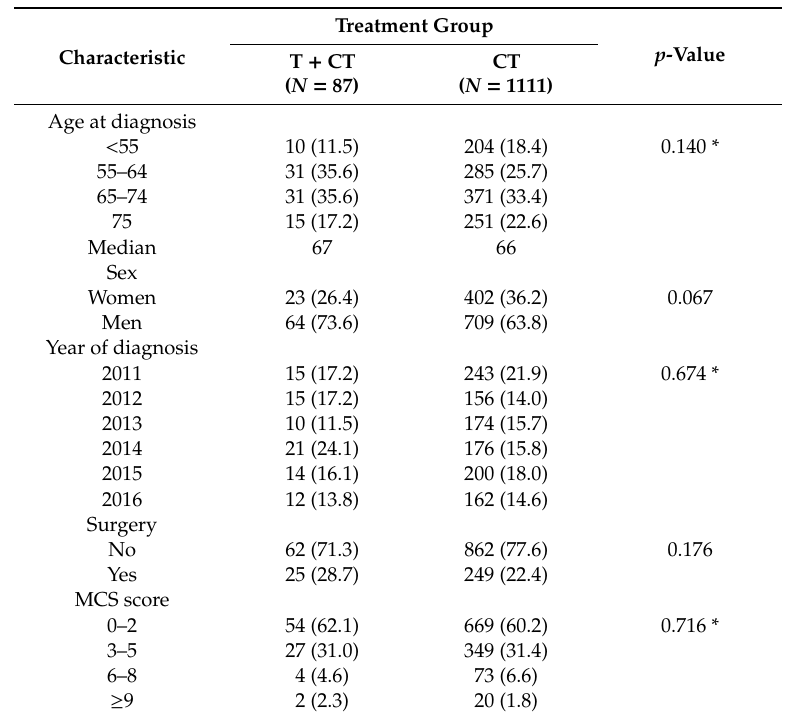
Table 1. Baseline characteristics of 87 metastatic gastric cancer patients treated with trastuzumab-based chemotherapy (T + CT) and 1111 patients treated with standard chemotherapy (CT).